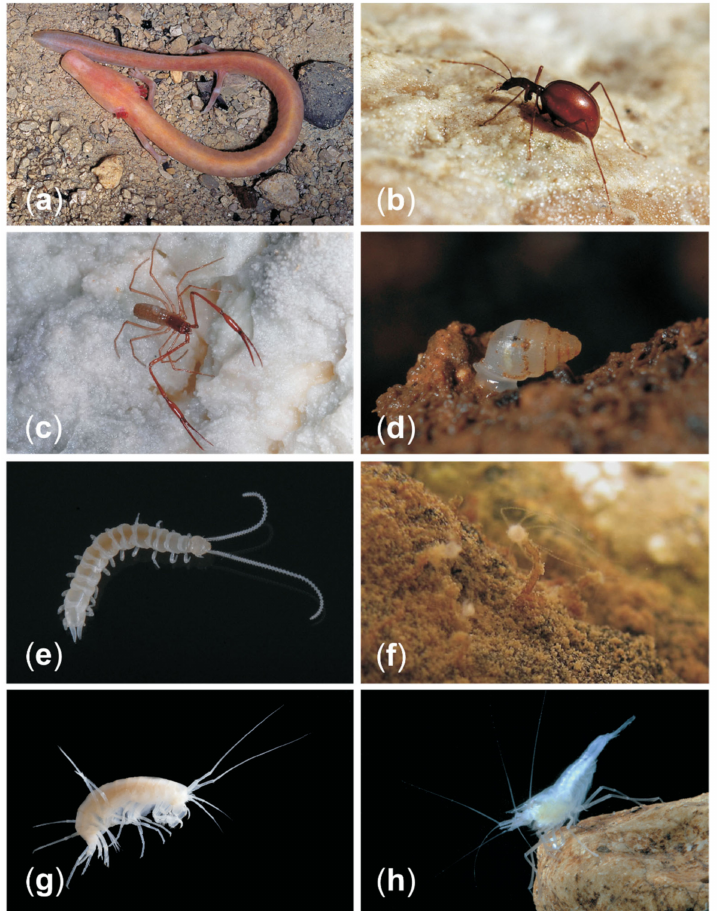
Figure 5. The famous eight: ( a ) proteus or the olm Proteus anguinus Laurenti, 1768; ( b ) slenderneck beetle Leptodirus hochenwartii hochenwartii Schmidt, 1832; ( c ) giant cave pseudoscorpion Neobisium spelaeum spelaeum (Schiødte, 1848); ( d ) Postojna cave herald snail Zospeum spelaeum spelaeum (Ross- maessler, 1839); ( e ) symphylan Scutigerella hauserae Scheller, 1990; ( f ) cave hydrozoan Velkovrhia enigmatica Matjašiˇc & Sket, 1971; ( g ) giant cave amphipod Niphargus orcinus Joseph, 1869; ( h ) Planina cave shrimp Troglocaris planinensis Birstein, 1948. Photo credits: ( a – e )—Slavko Polak, ( f )—Rodrigo Lopes Ferreira, ( g )—Teo Deli´c, ( h )—Rollin Verlinde. Not all species were reported from all caves of the PPCS. The highest number was reported from Planinska jama (66 species) and Postojnska jama (64 species). From